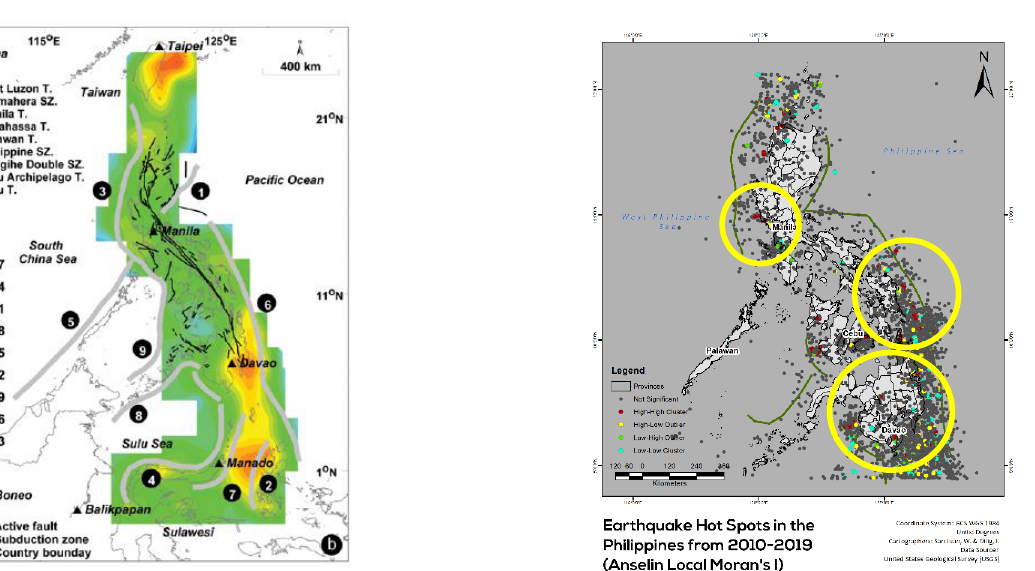
Figure 14. Maximum Earthquake Magnitude likely to be generated within 10 years